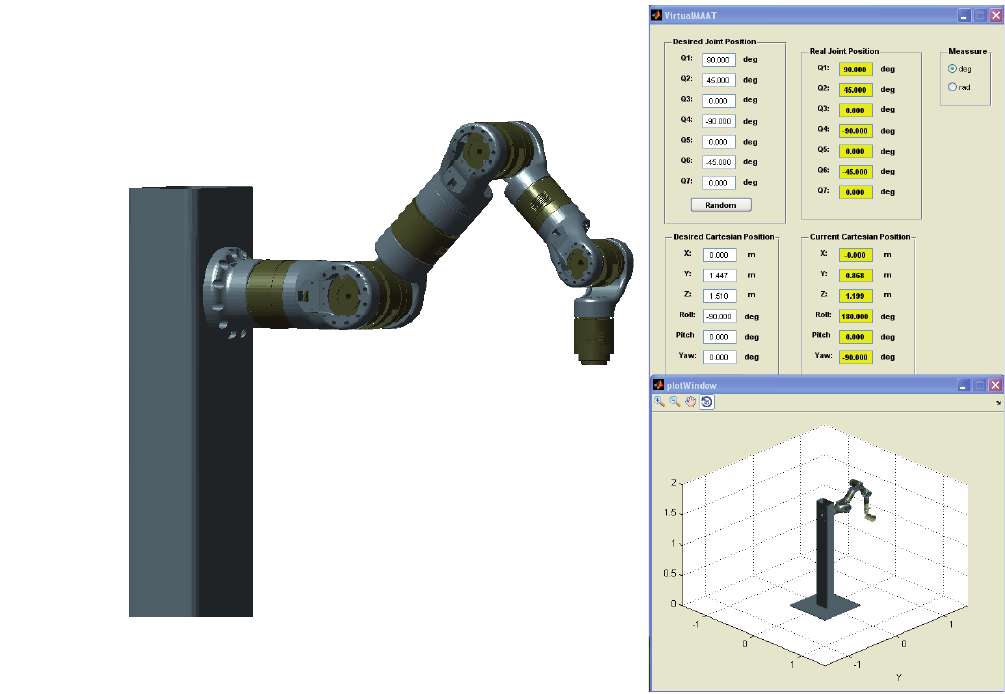
Figure 6. Experiments with different values of k